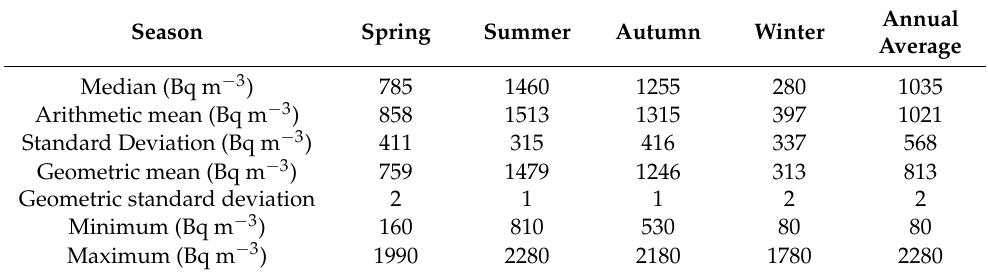
Table 2. Descriptive statistics of radon concentrations according to the measuring